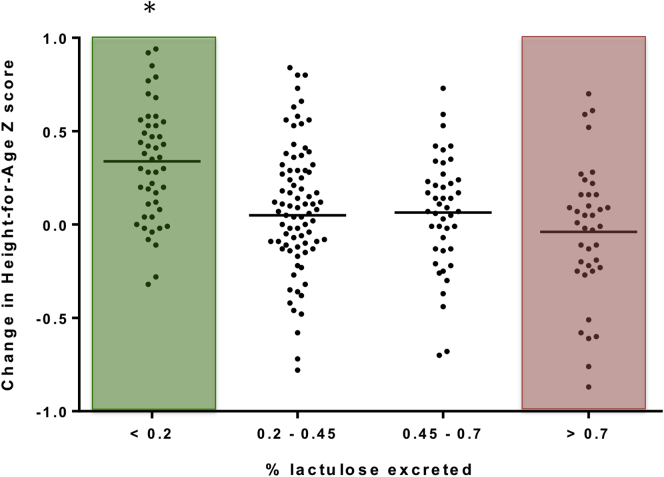
Association between EED assessed with a dual sugar absorption test and stunting in this population. Relationship between %L excretion and linear growth, expressed as the change in height-for-age Z-score in the subsequent 3-month period. Data are expressed as means. *Significantly different means from normal children using the Student t test with Tukey correction (P < .01). The green bar represents children without EED showing excellent growth, and the red bar represents children with severe EED showing no growth.